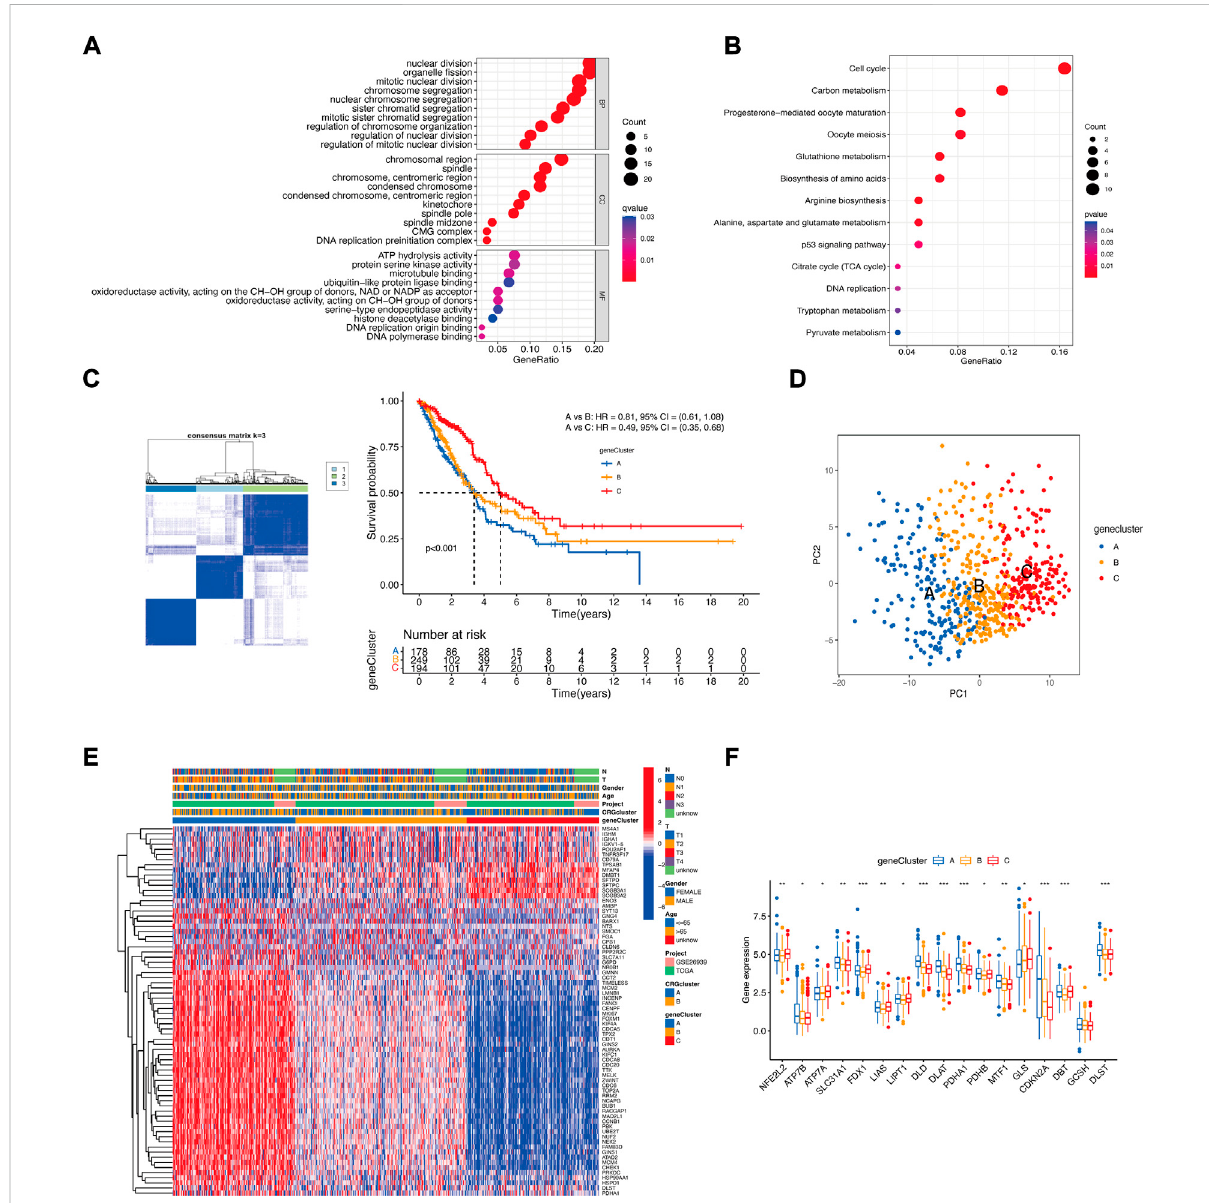
FIGURE 4 The landscape of the biological characteristics of cuproptosis gene cluster. (A) GO enrichment analysis of DEGs. BP: biological process, CC: cellular component, MF: molecular function. (B) KEGG enrichment analysis ofDEGs. (C) Clustering of LUAD patients based on DEGs associated with the cuproptosis subtypes. Consensus clustering matrix for k = 3. Kaplan − Meier plot of the gene clusters and overall survival probability. (D) PCA of three gene clusters. (E) Clinical characteristics of the three gene clusters. (F) CRG expression differences among the three gene clusters (Kruskal – Wallis test; * p < 0.05; ** p < 0.01; *** p <